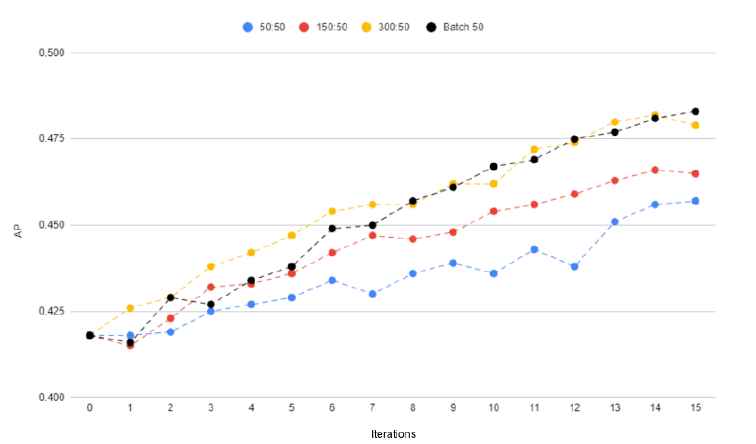
Figure 9. AP for networks trained with only part of the samples used in previous iterations.